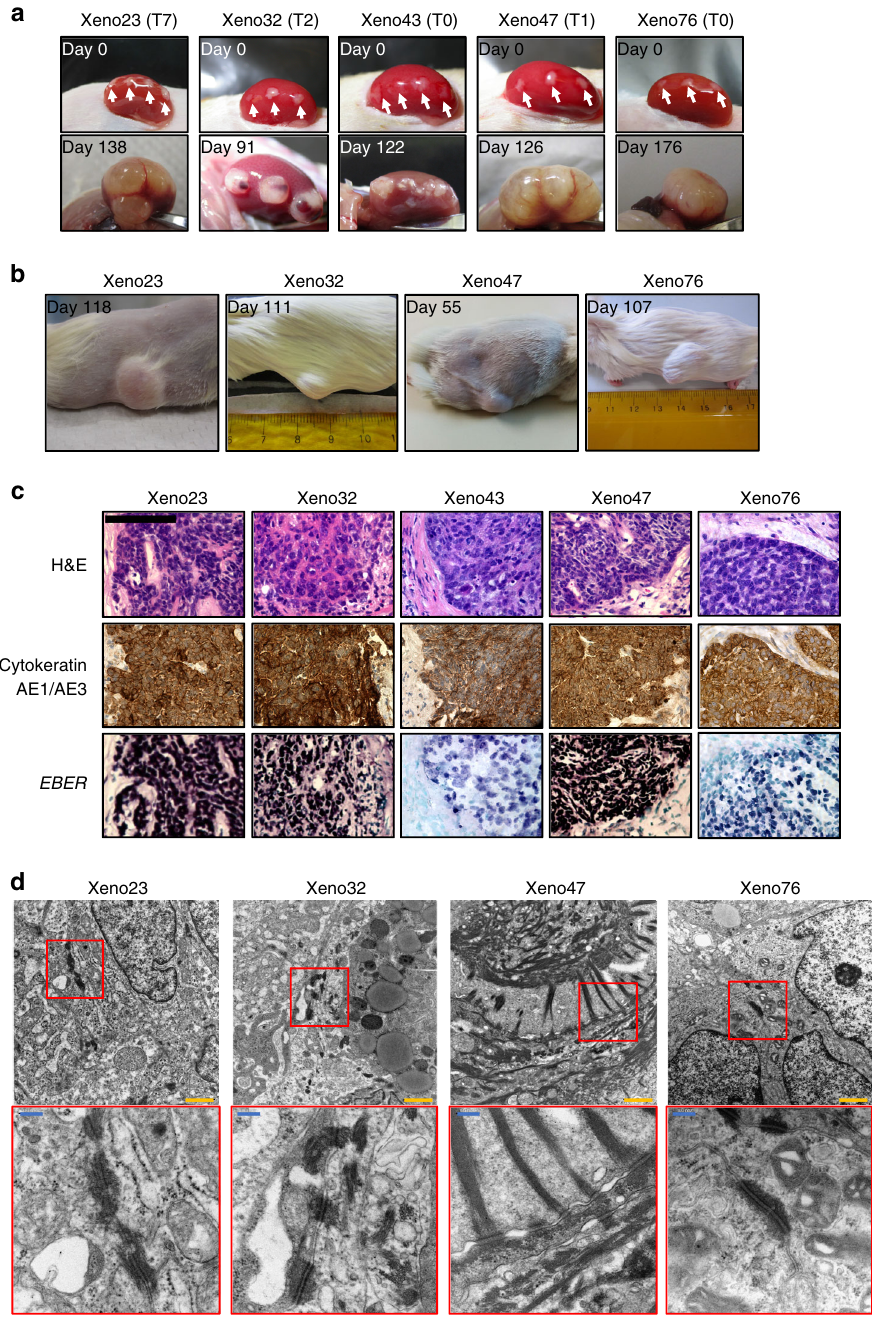
Fig. 1 Establishment of NPC PDXs in immunode fi cient mice. a Upper panels: Establishment of NPC PDXs (Xeno23, 32, 43, 47 and 76) was achieved by implantation of patient NPC tissues (white arrows) under kidney capsules in NOD/SCID mice. Lower panels: Growth of PDXs observed in the same mice at 138, 91, 122, 126 and 176 days respectively after implantation. b The growth of NPC PDXs (Xeno23, 32, 47 and 76) was observed in NOD/SCID mice at 118, 111, 55 and 107 days after subcutaneous implantation. c H&E, immunohistochemical staining of cytokeratin AE1/AE3 and EBER ISH were performed in consecutive sections of all fi ve NPC PDXs. The results of H&E staining con fi rmed that the PDXs were undifferentiated NPC. The epithelial nature of these PDXs and the presence of EBV were con fi rmed by the expression of keratin and EBER , respectively. Scale bar, 100 μ m. d The presence of desmosomes and different abundance of tono fi laments in four PDXs (Xeno23, 32, 47 and 76) as revealed by transmission electron microscopy, con fi rming the epithelial origin of the tumor cells. Scale bars: 1 μ m (yellow); 200 nm